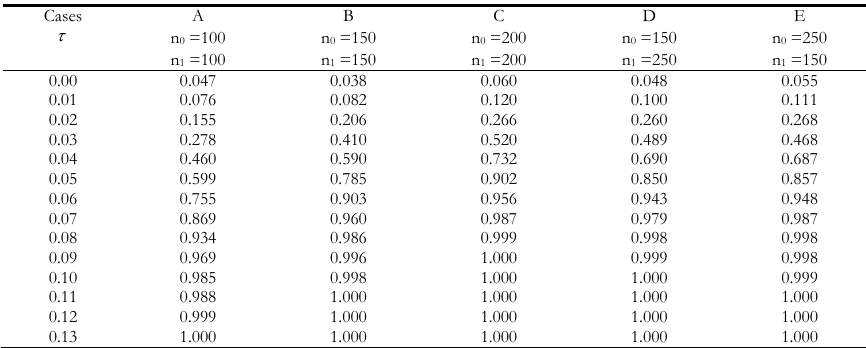
Simulated probability of rejecting H 0 , given 0 τ